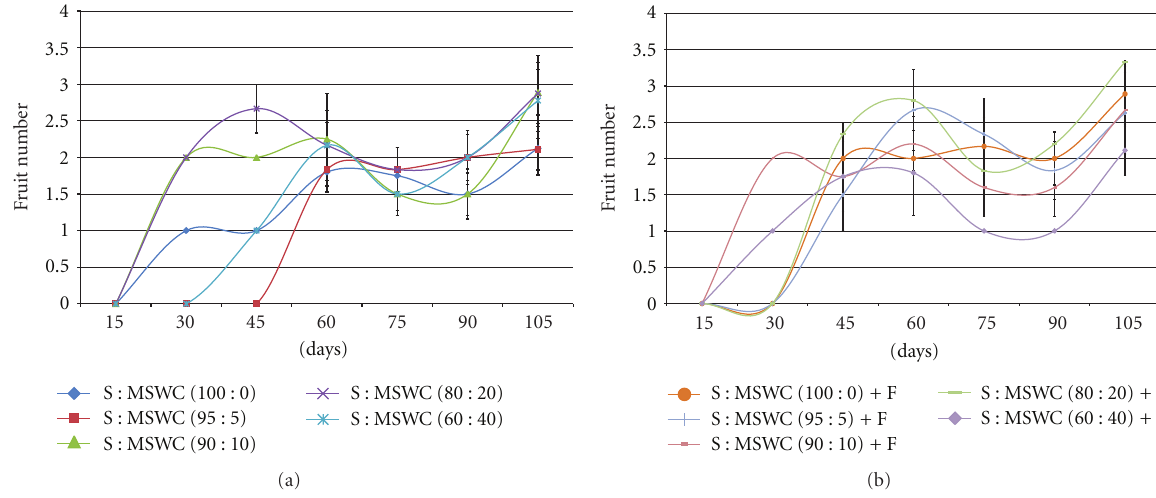
Figure 4: E ff ects of municipal solid waste compost (MSWC) into soil (S) without (a) or with (b) fertigation (F) on fruit number produced in greenhouse pepper crop. Values represent mean ( ± SE) of measurements made on six plants per treatment.